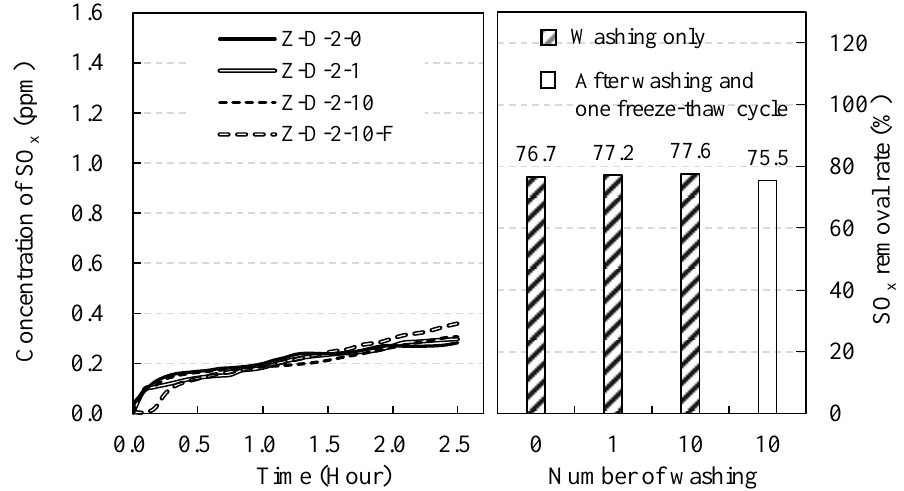
Figure 9. Typical SO x removal rate of textile fabrics coated with zeolite after exposure to external environmental conditions.